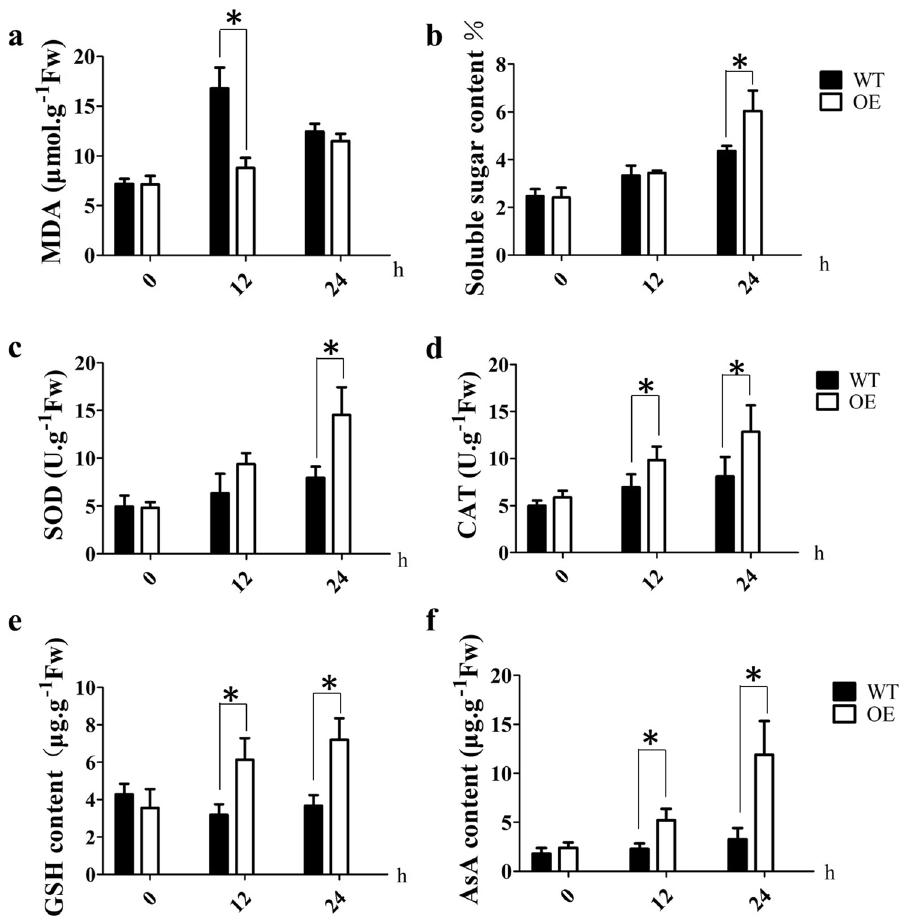
Figure 2. Physiological indices of the OsDRAP1 transgenic plants (OE-7) and wild type (WT) after 0 h, 12 h and 24 h of salt stress treatment. ( a ) Malondialdehyde (MDA) content. ( b ) Soluble sugar content. ( c ) Superoxide dismutase (SOD) activity. ( d ) Catalase (CAT) activity. ( e ) Glutathione (GSH) content. ( f ) Ascorbic acid (AsA) content. The asterisk indicates a significant difference determined by Student’s t -test ( p < 0.05 with three